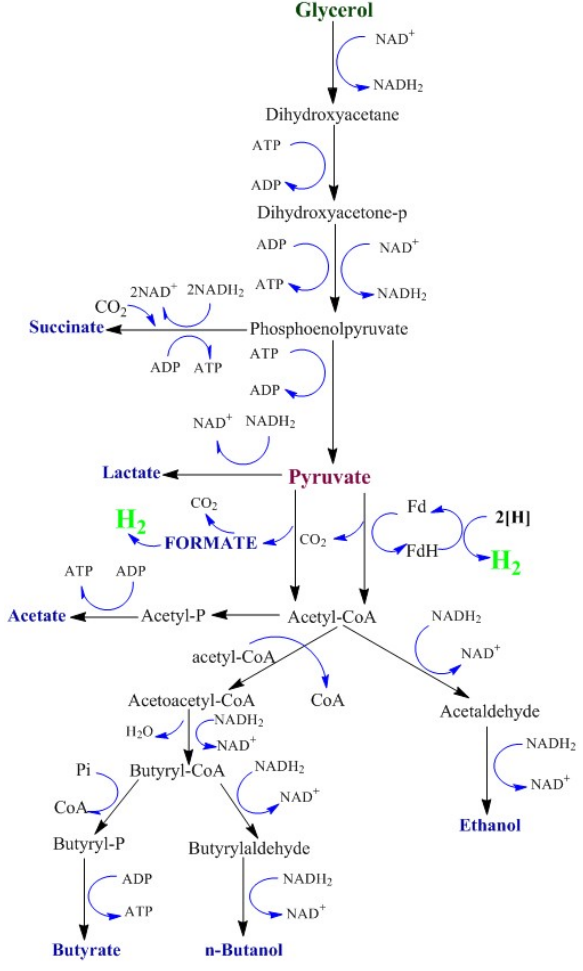
Figure 6. Production of hydrogen and volatile fatty acids by different metabolic routes, with different microorganisms from glycerol. Adapted by [38,39].